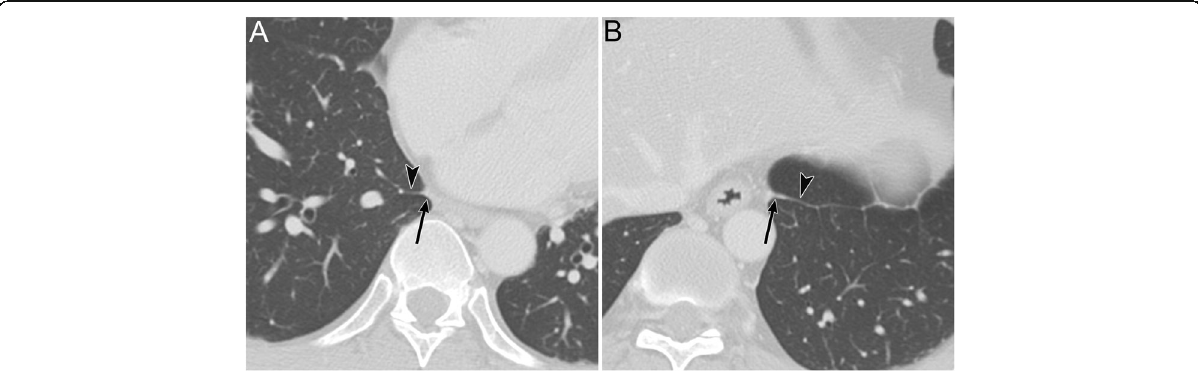
Fig. 17 The normal inferior pulmonary ligament (IPL) on CT. A 48-year-old man with chronic obstructive pulmonary disease. a An axial CT image of the right lung at the lung base shows the right IPL (black arrow). It appears as a beak that extends laterally from the mediastinum (between the IVC and the azygos vein) with the intersublobar septum (black arrowhead) . b An axial CT image of the left lung at the lung base shows the left IPL (black arrow). It appears as a beak that extends laterally from the mediastinum (along the esophagus) with the intersublobar septum (black